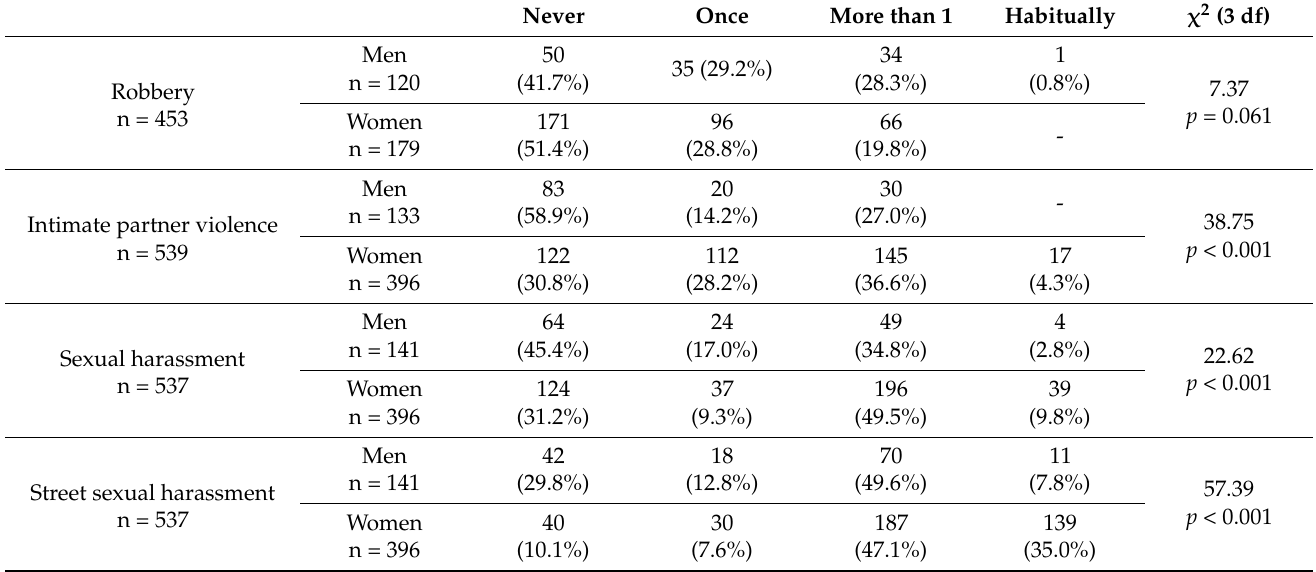
Table 5. Differences in frequency of experiences as violence witness by